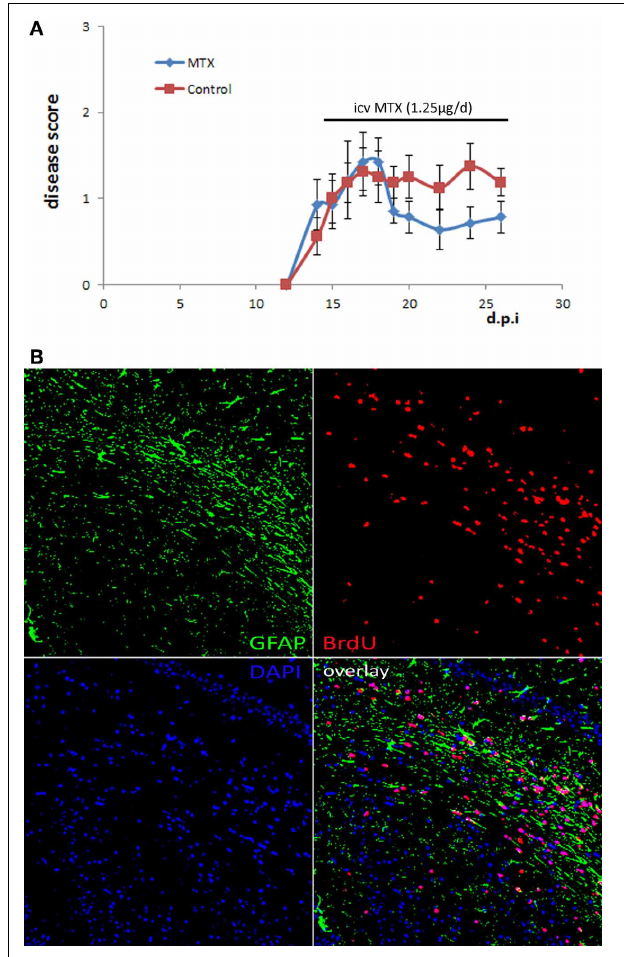
FIGURE 1 | Osmotic pumps delivering MTX/PBS were functional. (A) Active EAE was induced in 16 female C57Bl/6 mice. Half of the mice received icv MTX (1.25 µ g per day) starting at day 14 after disease induction, control mice received PBS instead. Error bars represent the standard error of the mean. (B) Representative BrdU staining of brain sections of a mouse that was treated with MTX/BrdU delivered by osmotic pumps for 4 weeks showing that BrdU was delivered into the brain implying that the respective animal also received methotrexate (200 ×